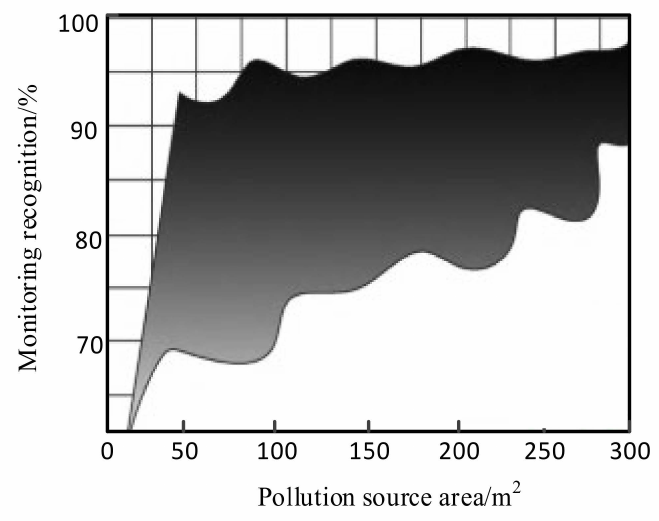
Figure 3. Identification degree-simulated pollution source area